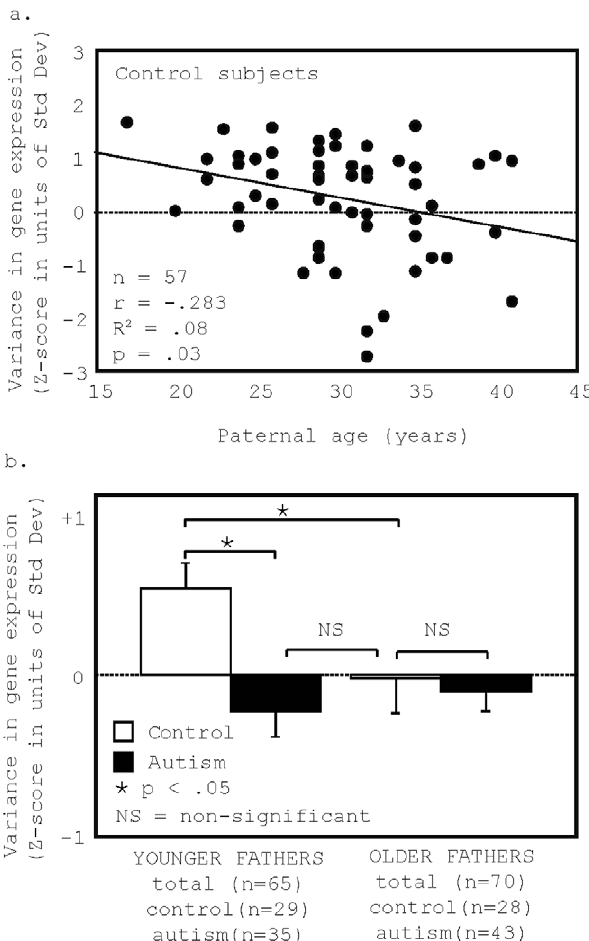
Figure 3. Increased paternal age at birth is negatively associated with overall variance in gene expression in peripheral blood lymphocytes (PBL) of normal children. Paternal age at birth was found in multiple studies to be a risk factor for autism [26,28,34,35]. Previous work indicated that factors or interventions that modified mouse hippocampal-dependent behavior also modified the overall variance in gene expression in the predicted direction. In controls (figure 3a) but not in children with autism (not shown), overall variance in log-transformed measures of gene expression was significantly and negatively associated with paternal age at birth (r=-.283, R 2 =.08, p=.03, number of subjects =57). For the evaluation of paternal age effects, paternal ages were available for 78 children with autism and 57 control children. To directly compare overall microarray variance in children with autism to children of older fathers, we divided subjects by the median paternal age at birth in our study (31 years) and created 2 groups: 1) children from younger fathers (less than 31 years) (65 subjects: 30 controls and 35 children with autism); and 2) children from older fathers (31 years or older) (70 subjects: 27 controls and 43 children with autism). We compared mean levels of overall variance between children with autism and controls of older and younger fathers. As predicted, we found that overall variance was the same in children of older fathers and children with autism with fathers of any age (figure 3b). We found that the association of autism with decreased overall variance was only found in children of younger fathers and represented a difference of .78 standard deviations within our sample (p=.0007) (figure 3b). Error bars represent standard